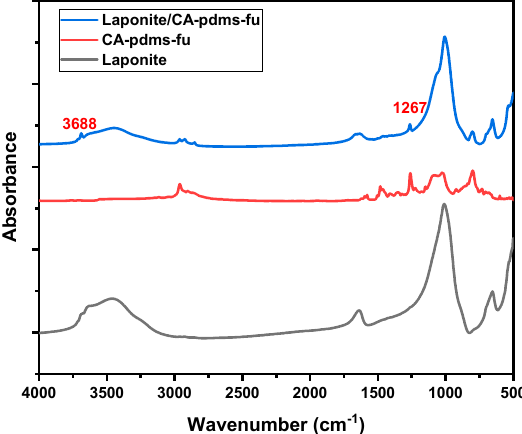
Figure 11. FTIR spectra of Laponite / CA-pdms-fu, CA-pdms-fu and laponite.